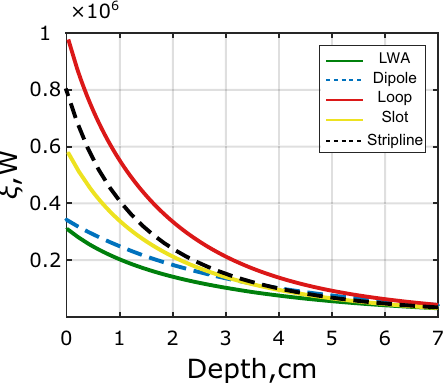
Fig. 3 Comparison of different MRI coil types according to their reactive near fi elds. Figure of merit based on the difference between electric and magnetic energy density as de fi ned in equation (1) for different coil types equally fed with 1 W of accepted power as a function of depth in the